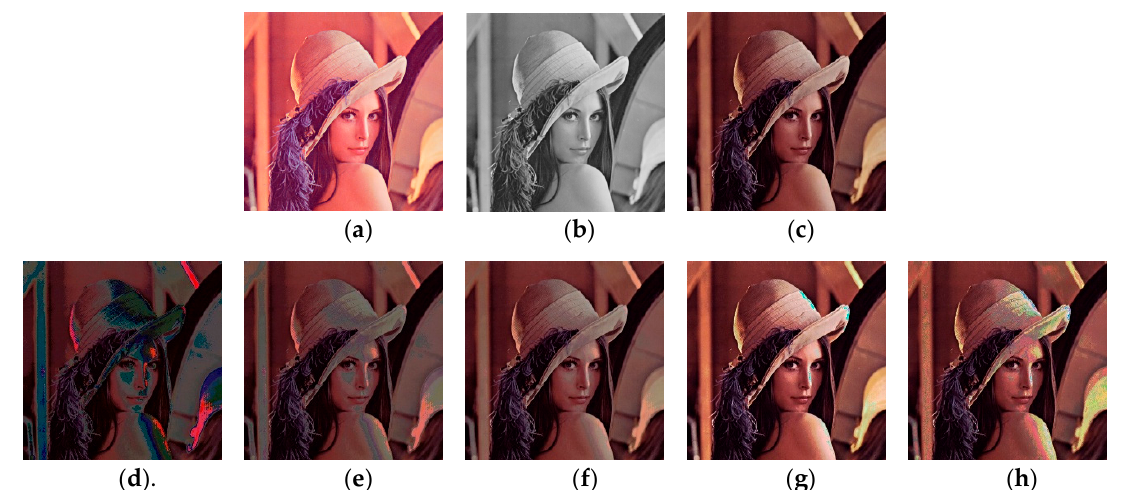
Figure 12. Image multiplication results. ( a ) First input. ( b ) Second input. ( c ) Exact design. ( d ) 1st design. ( e ) 2nd esign. ( f ) 3rd design. ( g ) 4th design. ( h ) 5th design.